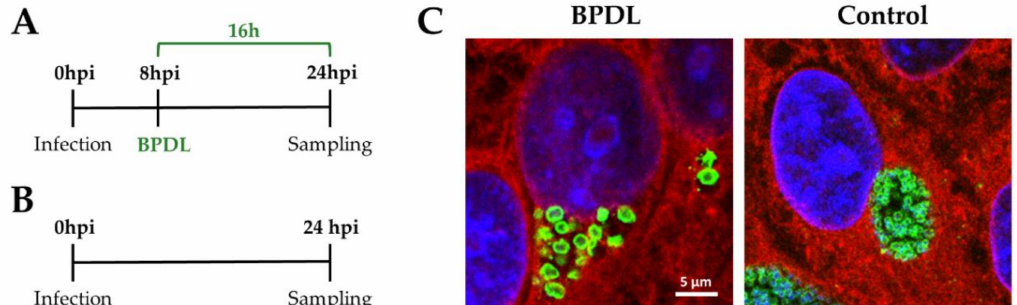
Figure 2. Formation of W. chondrophila aberrant bodies in the conditions used for the RNA-seq experiment. ( A ) Protocol for the treated samples (ABs): BPDL was added 8 hpi at a concentration of 75 µ M and samples were harvested 24 hpi. ( B ) For the untreated control (RBs), infected HEp-2 cells were harvested 24 hpi. ( C ) In parallel to the RNA-seq experiment, W. chondrophila infected HEp-2 cells were grown on glass coverslip in presence (left panel) or absence (right panel) of 75 µ M BPDL added 8 hpi. Infected cells were fixed 24 hpi, labelled with Concanavalin A (red), DAPI (blue) and anti- W. chondrophila antibodies (green) and observed by confocal microscopy to confirm the formation of ABs. Both pictures display the same